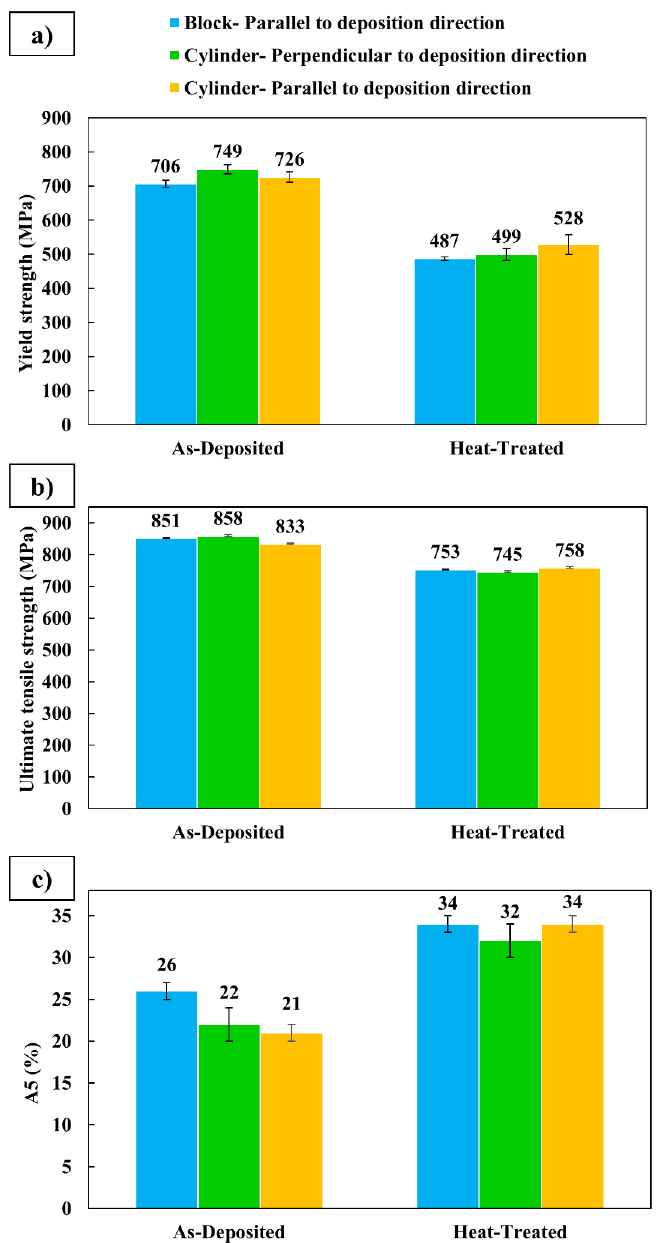
Figure 10. Tensile test results. ( a ) Yield strength, ( b ) ultimate tensile strength, and ( c ) elongation of block and cylinder in as-deposited and heat-treated conditions.